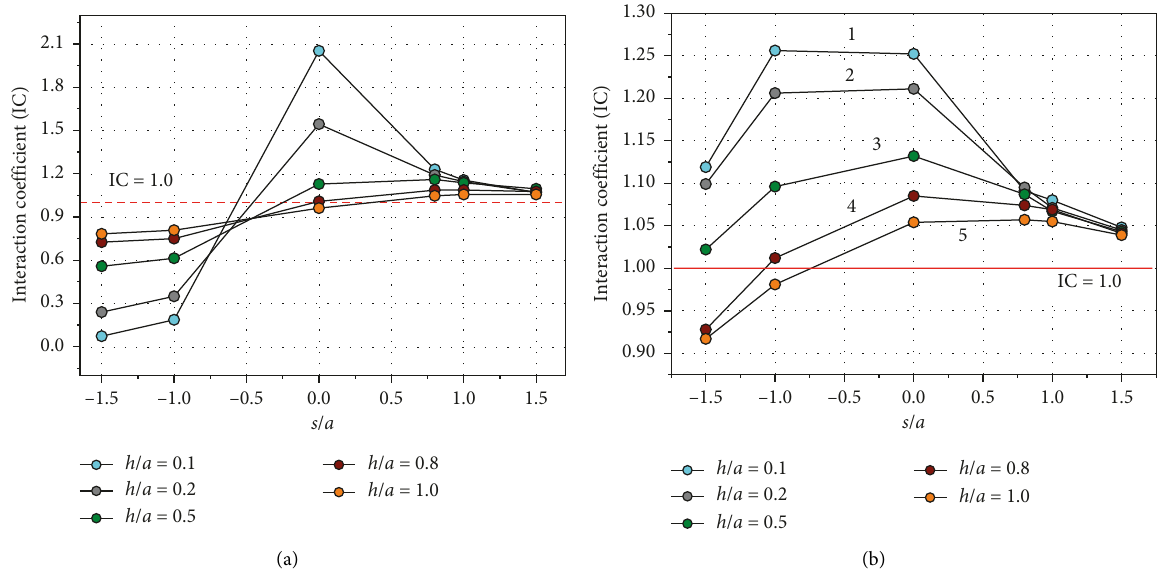
Figure 10: IC variations with length ratio of the rock bridge under unloading conditions. (a) Type I. (b) Type II.